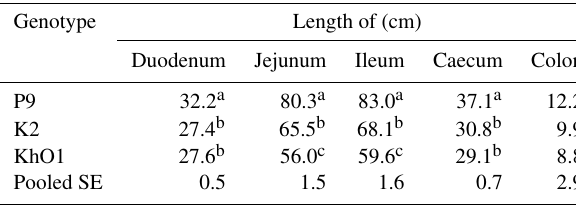
Table 1. Body weight, body, and intestine length and their ratio in spent ducks.